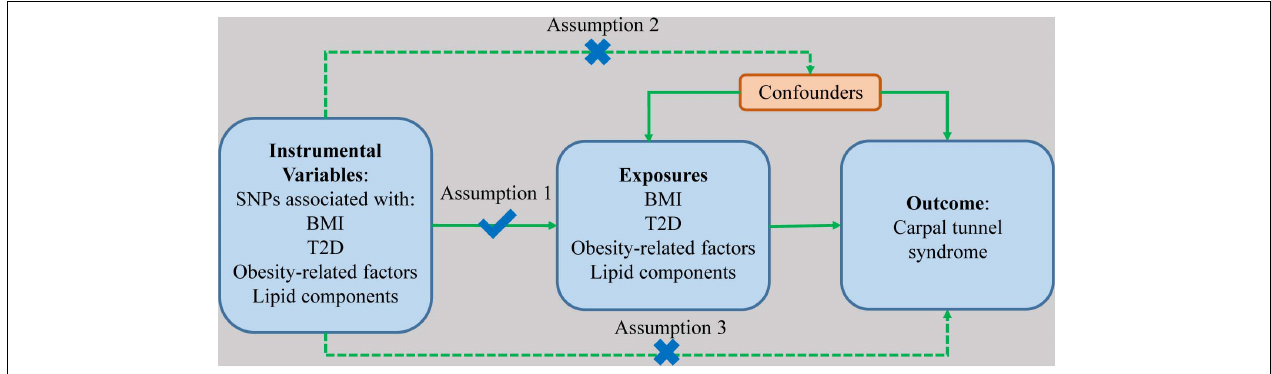
FIGURE 1 | The diagram of the study design and three assumptions of Mendelian randomization. The obesity-related exposures include arm fat mass, arm fat-free mass, and waist circumference. Lipid components include HDL-cholesterol, LDL-cholesterol, total cholesterol, and triglycerides. SNP, single nucleotide polymorphism; BMI, body mass index; T2D, type 2 diabetes.